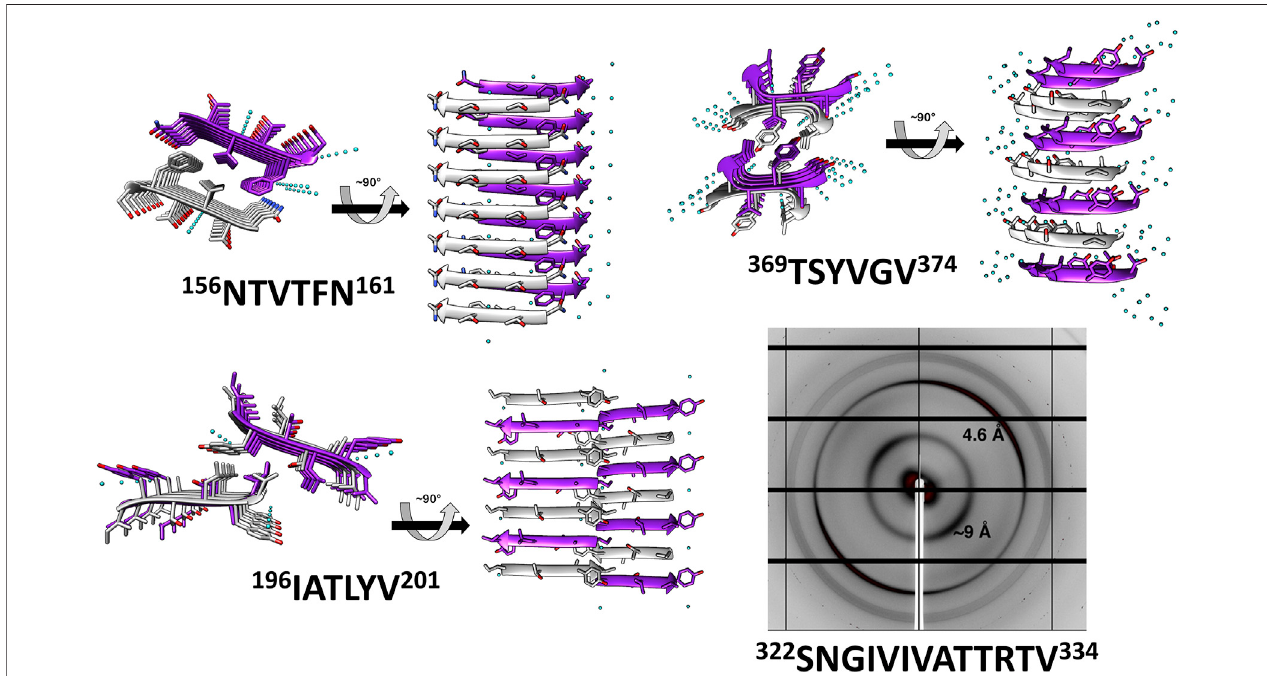
FIGURE 2 | Crystal structures and X-ray fi ber diffraction of Als5 amyloidogenic segments. High-resolution crystal structure of three predicted amyloidogenic segmentsofAls5andtheknownamyloidsegment 322 SNGIVIVATTRTV 334 .Theleftpanelofeachstructureisvieweddownthe fi brilaxis,with β -strandsshownasribbons and residues as sticks, while the right panel is viewed perpendicular to the fi bril axis displaying β -strands running horizontally. Fibrils contain thousands of layers of β - strands, but only seven layers are shown here. Segment backbones are colored either gray or purple; heteroatoms are colored according to their atom type (nitrogen in blue, oxygen in red) and water molecules in cyan. The X-ray fi ber diffraction pattern with major re fl ections labeled showing a cross- β pattern with orthogonal re fl ections at 4.6 Å and ~9 Å spacings. Some re fl ections originating from ice also appear.